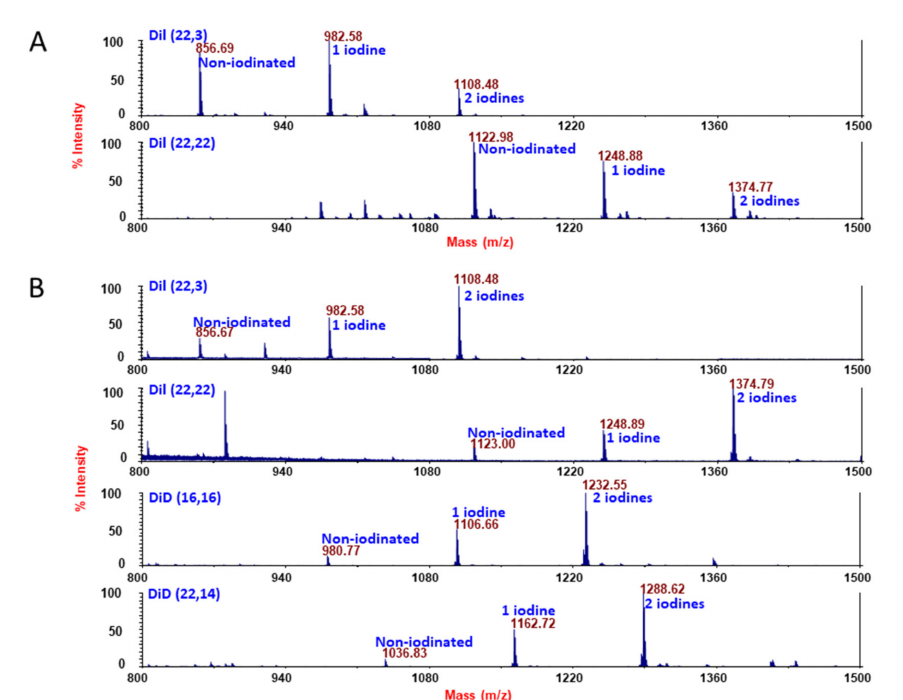
Figure 2. Iodination of phenolic DiI and DiD compounds. ( A ) Iodination with NaI was carried out using Iodogen precoated iodination as the first method described in Materials and Methods. The optimal ratios of tertiary butyl alcohol to phosphate-bu ff ered saline (PBS) were 50:50 for DiI (22,3) and 75:25 for DiI (22,22). Shown are the mass spectra acquired as positive ion reflector mode on a Sciex 4800 matrix-assisted laser desorption / ionization (MALDI) time-of-flight (TOF) / TOF instrument. ( B ) Iodination with NaI was carried out using Iodogen in solution as the second method described in Materials and Methods. Shown are the mass spectra acquired as in Figure